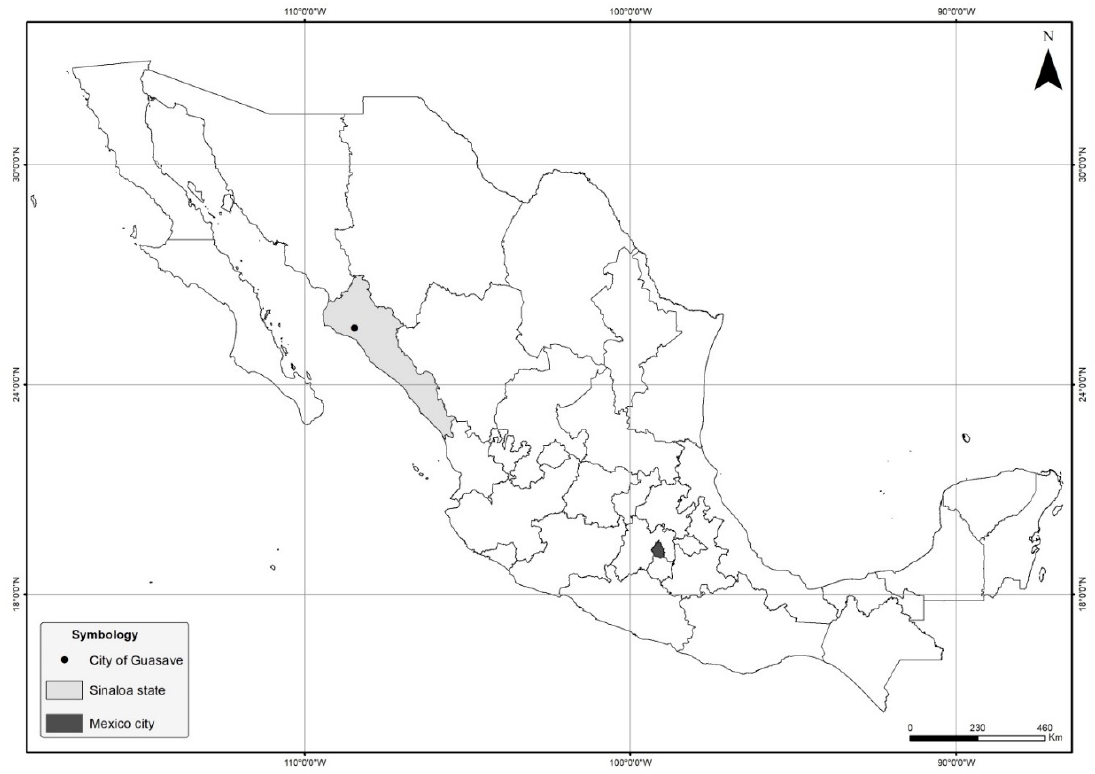
Figure 1. Location of city of the outbreak in Mexico. The city of Guasave is indicated by a black circle within the province of Sinaloa (grey). Mexico City, the place from which the bullfrogs were imported from, is shown in black.